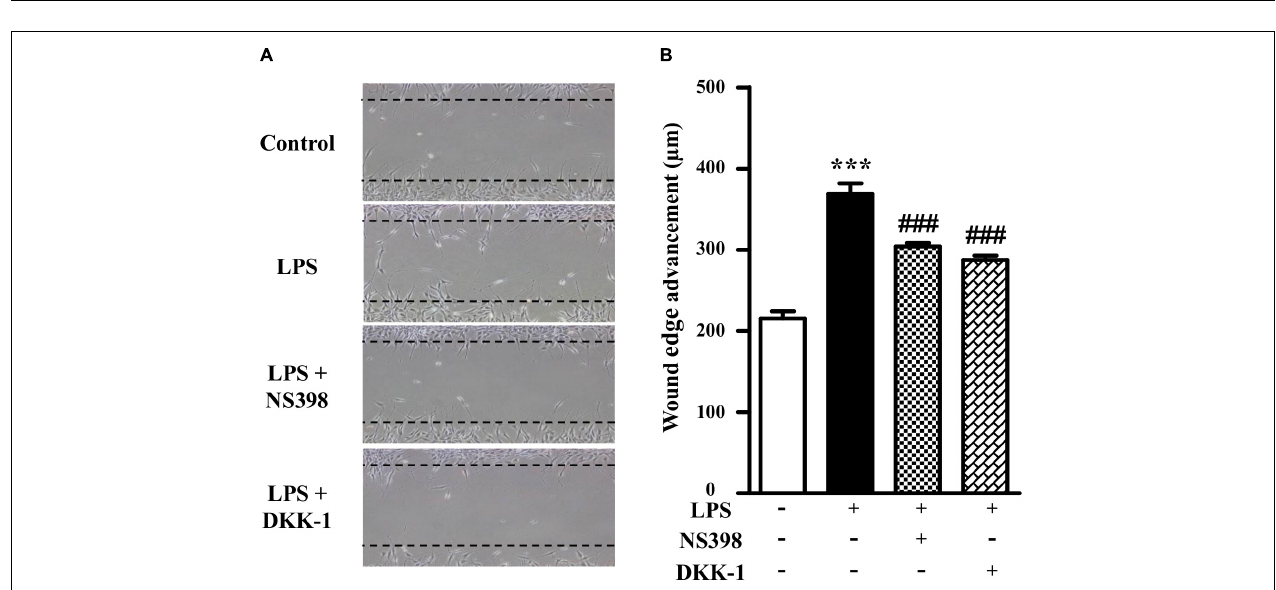
FIGURE 2 | Effects of LPS on the endogenous expression of COX-2 and β -catenin in NIH3T3 cells. Representative blots (A) and summary (B) of the COX-2 and β -catenin expression in NIH3T3 cells treated with or without LPS (400 ng/ml, 24 h); ∗∗∗ P < 0.001 vs. control, n = 5.